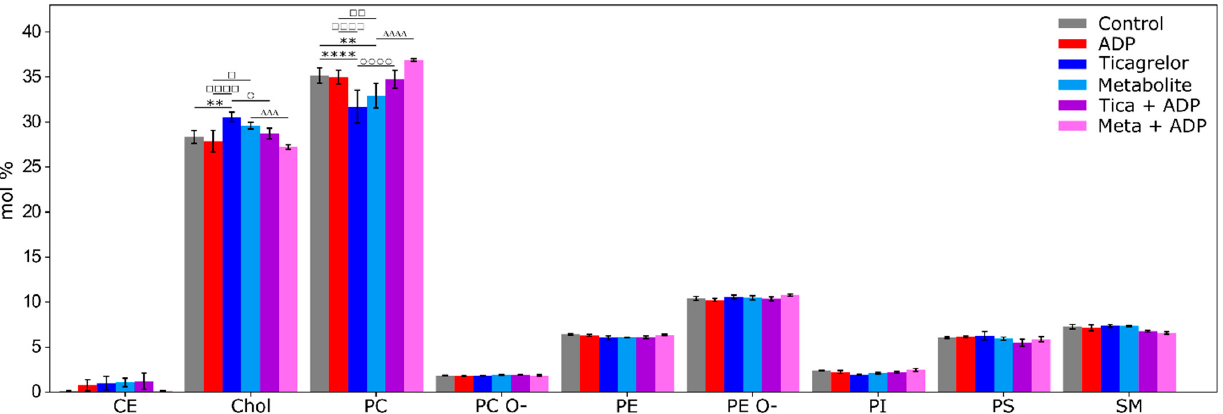
Figure 4. Lipid composition of the platelet plasma membrane according to the experimental groups. The results are expressed as mol% (mean ± SD) of lipid sub-classes. Cholesteryl esters (CE), cholesterol (Chol), phosphatidylcholines (PC), phosphatidylcholines ether (PC O-), phosphatidylethanolamines (PE), phosphatidylethanolamines ether (PE O-), phosphatidylinositols (PI), phosphatidylserines (PS), sphingomyelins (SM). Lipids below 1% of their sub-class are not represented. p -values were determined from two-way ANOVA (* = p < 0.05, ** = p < 0.01, *** = p < 0.005, **** = p < 0.001 compared to the control group ; □ = p < 0.05, □□ = p < 0.01, □□□ = p < 0.005, □□□□ = p < 0.001 compared to the adenosine diphosphate (ADP) group, ○ = p < 0.05, ○○ = p < 0.01, ○○○ = p < 0.005, ○○○○ = p < 0.001 compared to the Ticagrelor group ; ∆ = p < 0.05, ∆∆ = p < 0.01, ∆∆∆ = p < 0.005, ∆∆∆∆ = p < 0.001 compared to the Metabolite group).